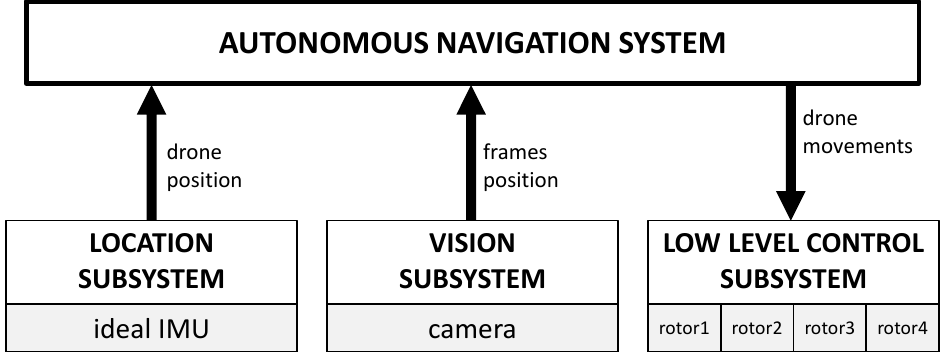
Figure 2. Dependences between the subsystems composing the framework.